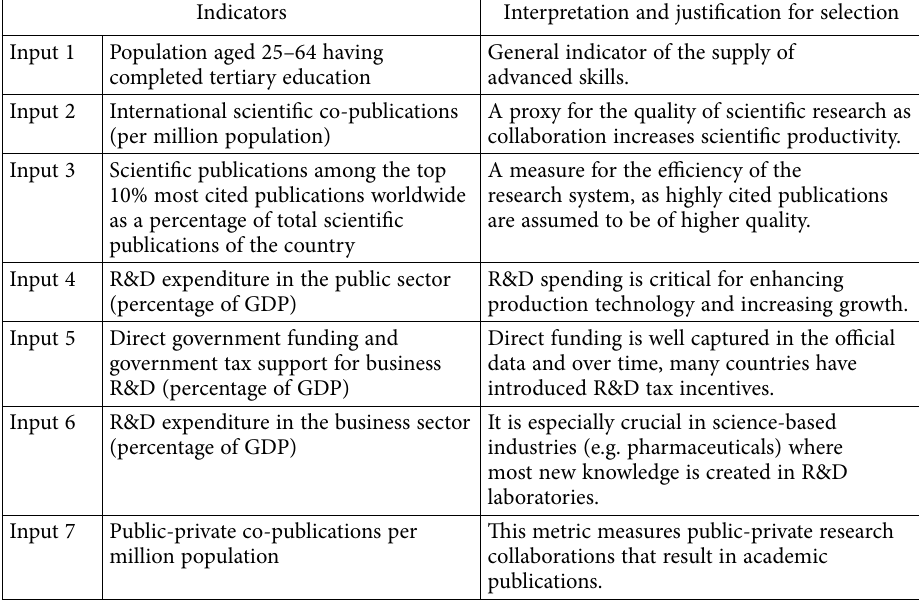
Table 1. Indicators used to measure innovation capability (input subindex) of an economy (source: author’s concept based on the European Innovation Scoreboard 2021 methodology)